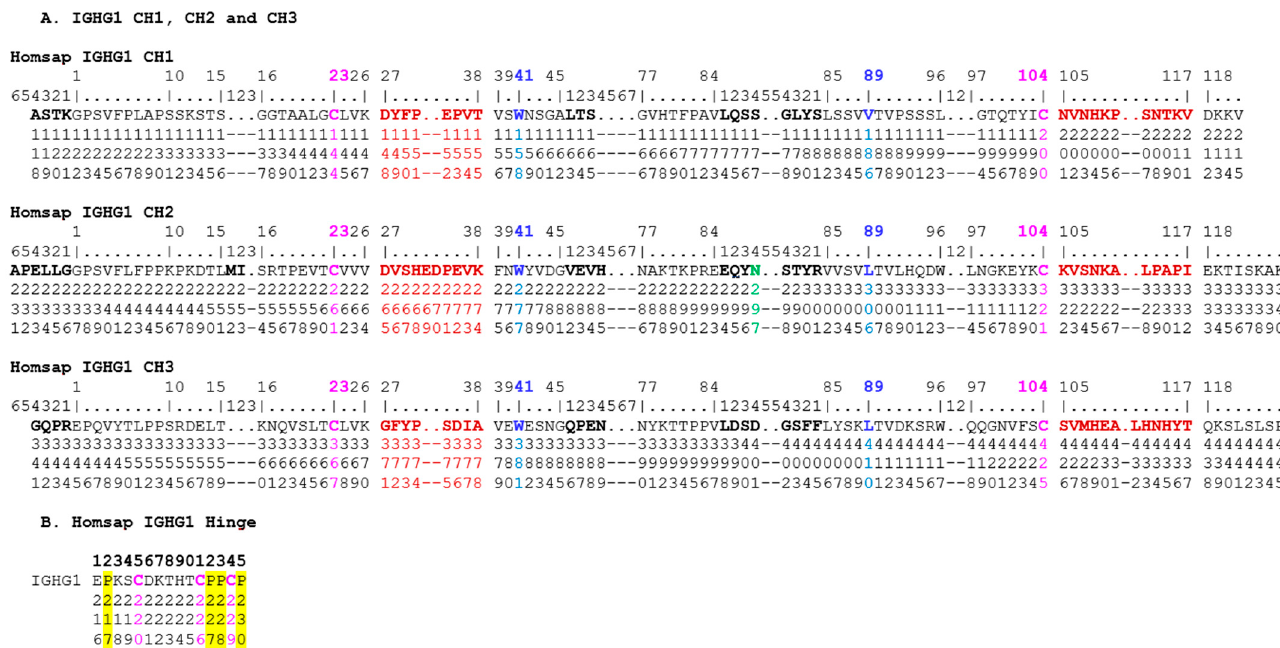
Figure 5. Correspondence between the Homo sapiens IGHG1 amino acid sequence, based on the IMGT unique numbering for the C-domain [68] and the Eu positions (shown vertically) from 118 to 445 [97]. ( A ) IGHG1 CH1, CH2 and CH3. The standardized presentation of the IMGT unique numbering on the top two lines [68] can be obtained using IMGT/DomainGapAlign [28,49,50], the IMGT reference tool for constant C-domain amino acid sequence analysis. The IMGT unique numbering for the CH1, CH2 and CH3 is shown on the first horizontal line with additional IMGT positions (by comparison to the V-domain IMGT unique numbering [67]) on line two. Amino acids at these additional positions are highlighted in bold. The Eu numbers are read vertically (on three lines top to down) at each position below the amino acid sequence. For example, the first amino acid of the Homsap IGHG1 CH1 is A1.4 (read G1, and going left, K1.1, T1.2, S1.3 and A1.4) and corresponds to Eu 118 (below A, read one top line, one second line and eight third line). The last amino acid of CH1 is a V, at position IMGT 121 (3 dots after 118), and corresponds to Eu 215 (below V, read two top line, one second line and five third line). The first amino acid of the Homsap IGHG1 CH2 A1.6 corresponds to Eu 231, whereas the last one, K, at position IMGT 125 (7 dots after 118), corresponds to Eu 340. The first amino acid of the Homsap IGHG1 CH3 G1.4 corresponds to Eu 341, whereas the last one, P, at position IMGT 125, corresponds to Eu 445. The first amino acid of the CH1, hinge, CH2 and CH3 results from the splicing. The four conserved amino acids of the C-DOMAIN C23, W41, hydrophobic 89 and C104 are highlighted in colors (C23 and C104 in pink, W41 and hydrophobic 89 (V, L) in blue). The four AA and IMGT positions C23, W41, hydrophobic 89 and C104 correspond, respectively, to Eu 144, 158, 186 and 200 in CH1, 261, 277, 306 and 321 in CH2, and 367, 381, 410 and 425 in CH3. The CH2 asparagine N84.4 of the N-glycosylation site corresponds to Eu 297 (colored in green). The amino acids of the C-domain BC-LOOP and FG-LOOP (Table 4) are highlighted in bold and brown color. ( B ) Homsap IGHG1 hinge. The hinge IMGT 1 to 15 corresponds to Eu 216 to 230. Cysteines (C) and prolines (P) with Eu positions are highlighted in pink and yellow, respectively. (Drawn by Marie-Paule Lefranc and Gérard Lefranc, LIGM, Founders and Authors of IMGT ® , the international ImMunoGeneTics information system ® , https://www.imgt.org, Copyright 2022.)